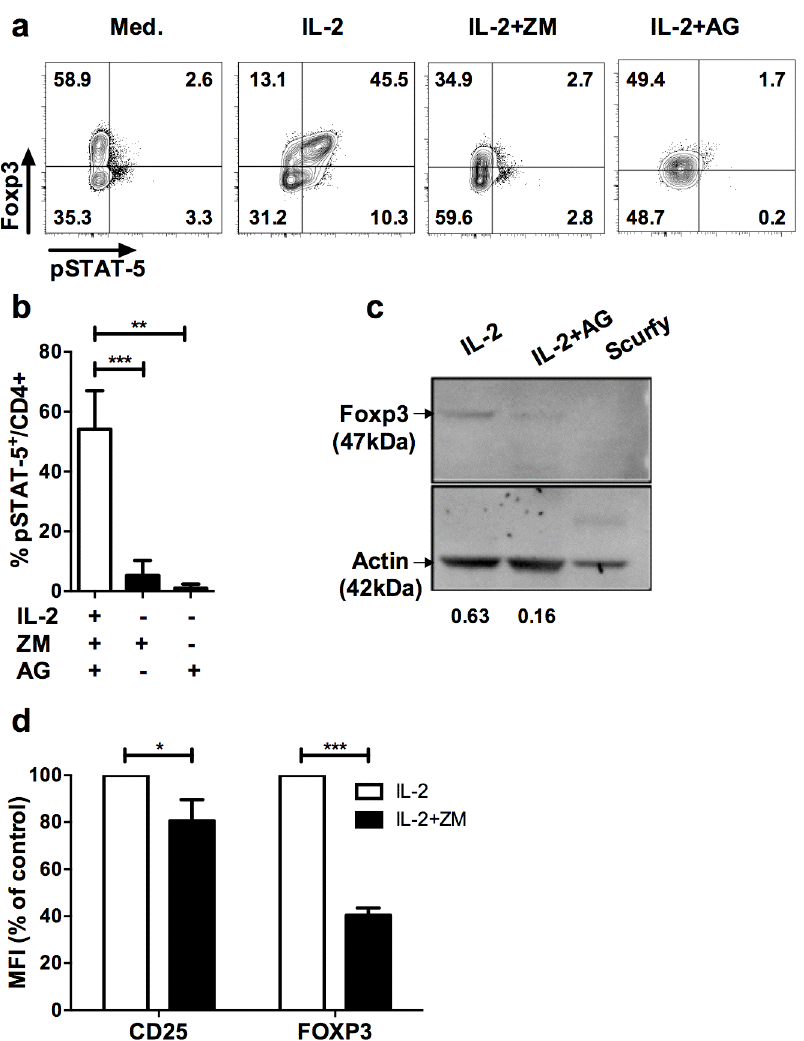
Fig 1. Blockade of JAK/STAT signaling pathway leads to down modulation of Foxp3 in Treg. ( a ) CD25-enriched T cells were cultured for one hour in complete medium alone (Med.), with IL-2 (IL-2), or IL-2 supplemented with ZM-39923 (IL-2+ZM) or AG-490 (IL-2+AG). Profiles shown are gated in CD4 + cells and are representative of 4 independent experiments. ( b ) Frequencies of pSTAT5 + cells among CD4 + cells cultured for one hour with IL-2 alone (IL-2) or in presence of IL-2 and the indicated JAK inhibitors (ZM, AG). Results are compiled from 4 independent experiments. (c) In vitro expanded CD4 + GFP + Treg were treated with IL-2 and with either 100ug/mL of AG490 (IL-2+AG) or vehicle control (absolute ethanol; EtOH) for 2 hrs (IL-2). Proteins were extracted in lysis buffer and blotted followed by anti-Foxp3 and anti-actin staining. Intensity values were normalized to the actin band in each blot. The specificity of the Foxp3 staining is attested by the absence of the Foxp3 band in extracts from splenocytes of a scurfy (genetically deficient for Foxp3) mouse. (d) Human CD4 + CD25 + cells were enriched from PBMC of healthy donors by magnetic sorting and treated with IL-2 (600 IU/mL) with or without ZM (50 μ M) for 1h. MFI of CD25 and FOXP3 in human CD4 + CD3 + cells after treatment with IL-2 alone (IL-2) or IL-2 in presence of ZM (IL-2+ZM). The MFI of Foxp3 and CD25 shown were normalized by the MFI of control cultures. These data are compiled from 3 independent experiments. Statistical significance was tested using Student t-test ( *** p < 0.001, ** p < 0.01, * p < 0.05).